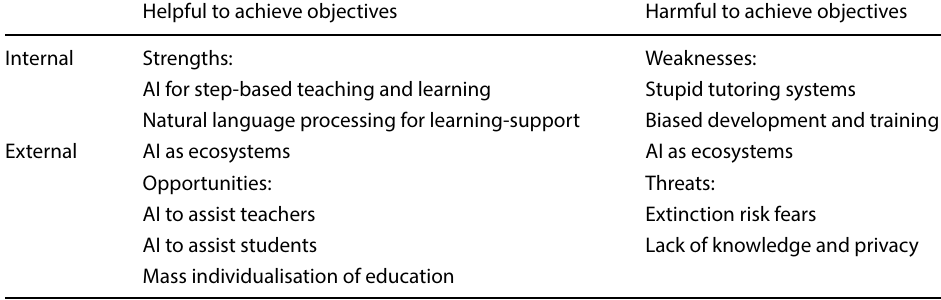
Table 2 Summary of themes related to the SWOT